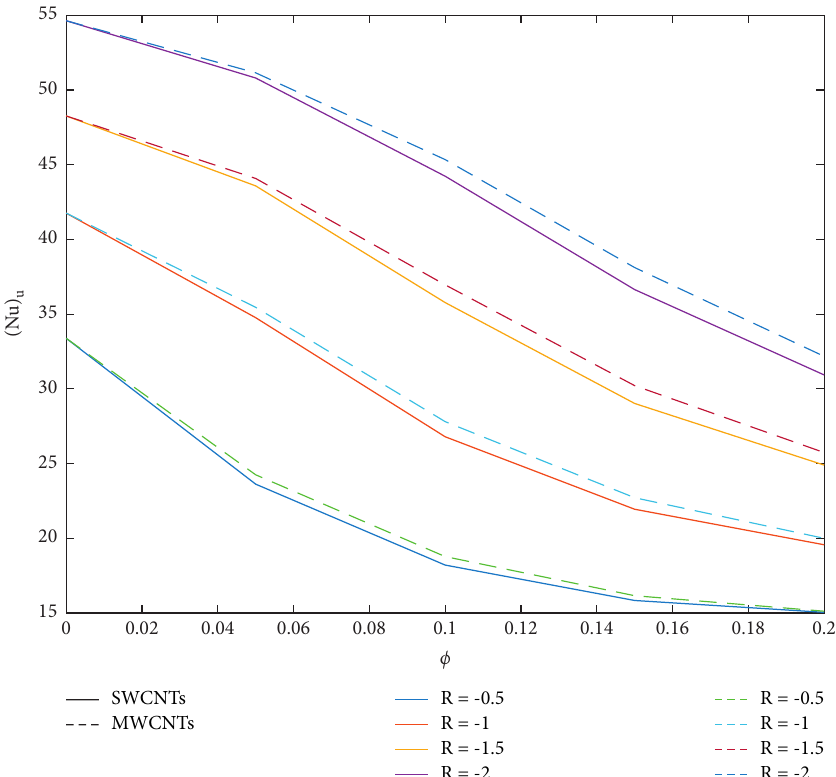
Figure 11: Nu vs. φ impact of R via S2HWs for the parameters α � − 2 . 5 , A ∗ � − 0 . 2 , Pr � 6 .